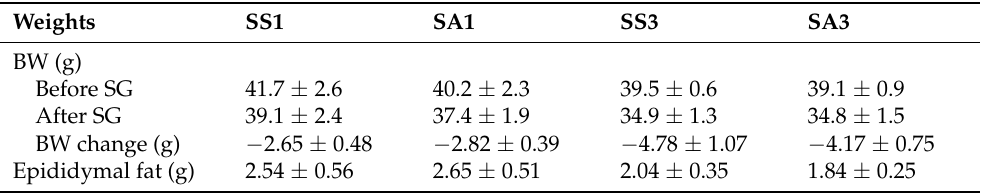
Table 1. Body weights (BW), weight changes, and epididymal fat weights of the experimental groups before and after the sleeve gastrectomy